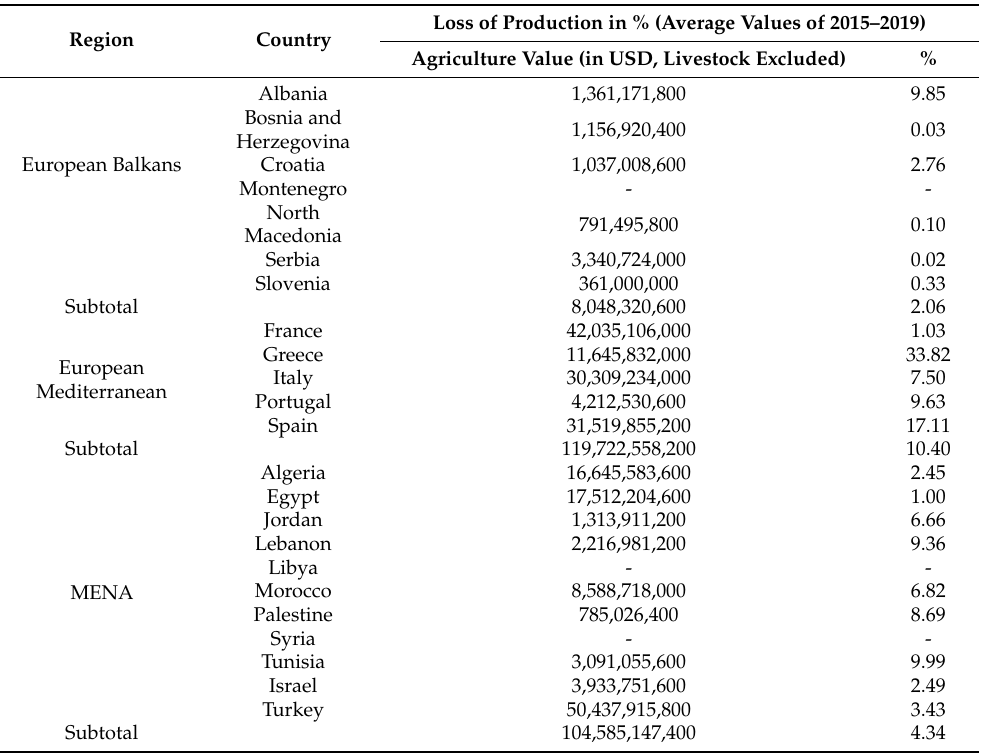
Table 4. Loss of production of Xylella fastidiosa on olives, grapes, Citrus spp., and almonds in the Mediterranean basin. Loss of Production in % (Average Values of 2015–2019) Region Country Agriculture Value (in USD, Livestock Excluded)